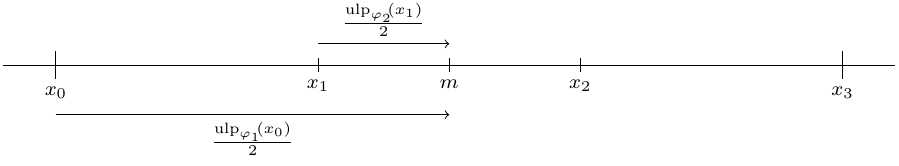
Fig. 3: Illustration of Lemma 17. In radix β = 3, with ϕ 2 = ϕ 1 − 1, x 0 and x 3 are consecutive values in F ϕ while x 0 , x 1 , x 2 and x 3 are consecutive values in F ϕ . The midpoint m in F ϕ 1 2 ulp ϕ 1 ( x 0 ) ulp ϕ 2 ( x 1 ) also a midpoint in F ϕ : m = x 0 + = x 1 + . This property relies on β being 2 2 2